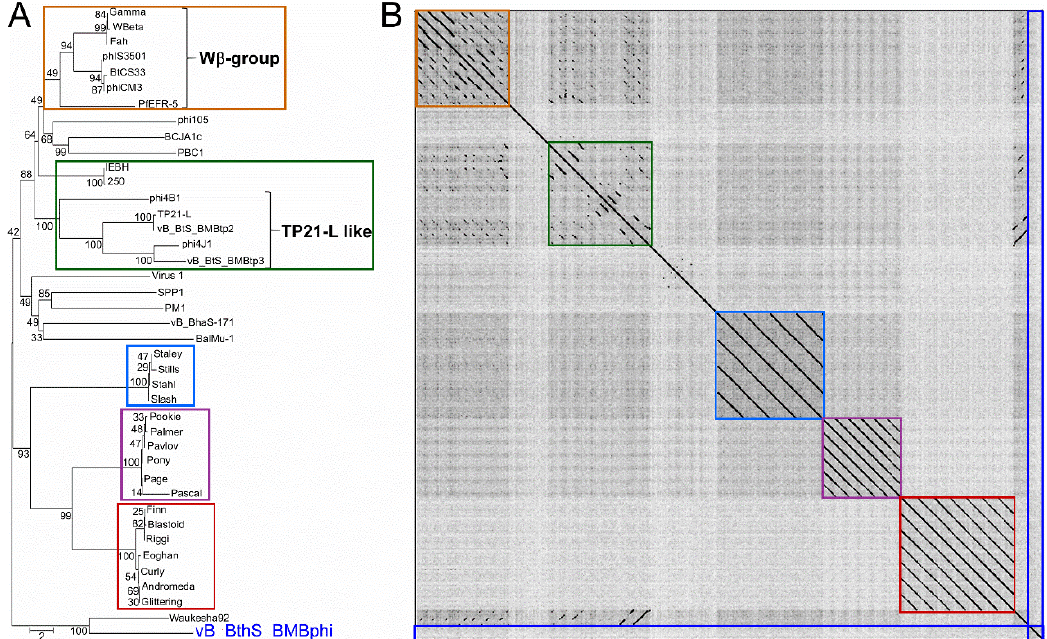
Figure 4. Phylogenetic and comparative analysis of vB_BthS_BMBphi. ( A ) Phylogenetic analysis of the Siphoviridae family phages infecting the Bacillus species. The genome sequences of 40 Siphoviridae family Bacillus phages were collected from GenBank and used for phylogenetic tree analysis together with the genome of the phage vB_BthS_BMBphi. ( B ) Comparative genomic analysis of vB_BthS_BMBphi. The genomes used for comparative genomic analysis were listed as in the order shown in Figure 4A. The information of the Bacillus phages used for phylogenetic and comparative genomic analysis is shown in Table S3.